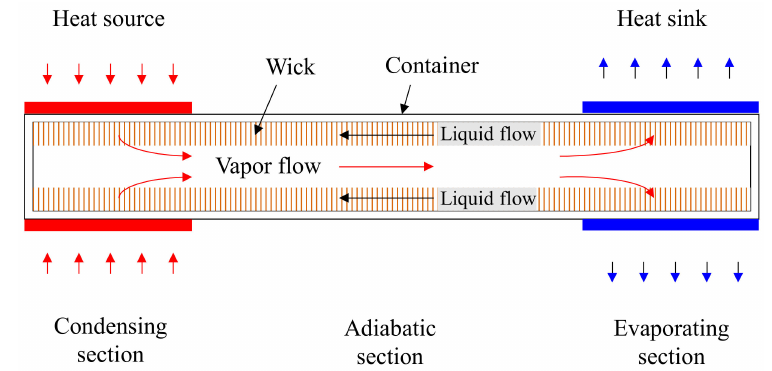
Figure 1. Schematic of a conventional heat pipe showing the principle of operation and circulation of the working fluid.